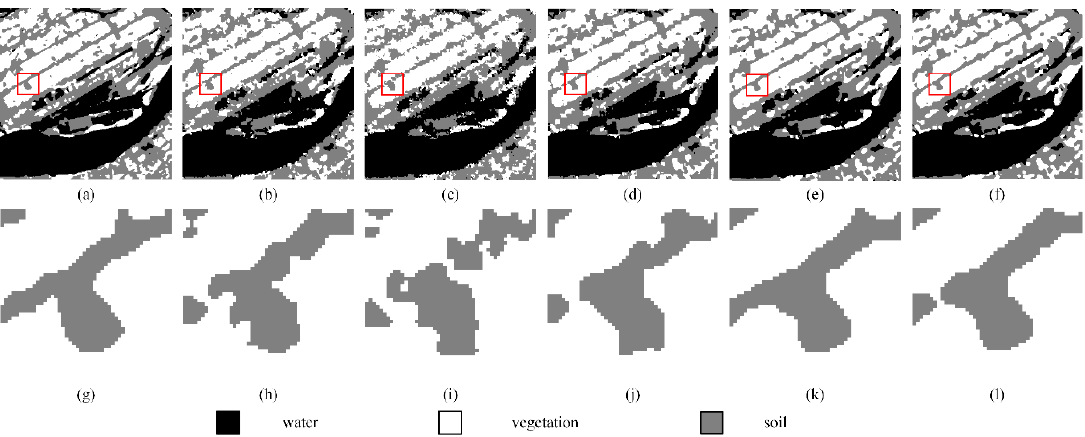
Figure 11. Comparison of the results from different SPM models for a real land image at a reconstruction scale of 8: ( a ) the reference image, ( b ) the PSA results, ( c ) the PSA_SA results, ( d ) the DSAM algorithm results, ( e ) the PSA_MSA1 algorithm results, ( f ) the PSA_MSA2 algorithm results, ( g ) the local details in the reference image, ( h ) the local details in the PSA results, ( i ) the local details in the PSA_SA results, ( j ) the local details in the DSAM algorithm results, ( k ) the local details in the PSA_MSA1 algorithm results, and ( l ) the local details in the PSA_MSA2 algorithm results. Table 5. Accuracy (%) results of different models for a real land image.